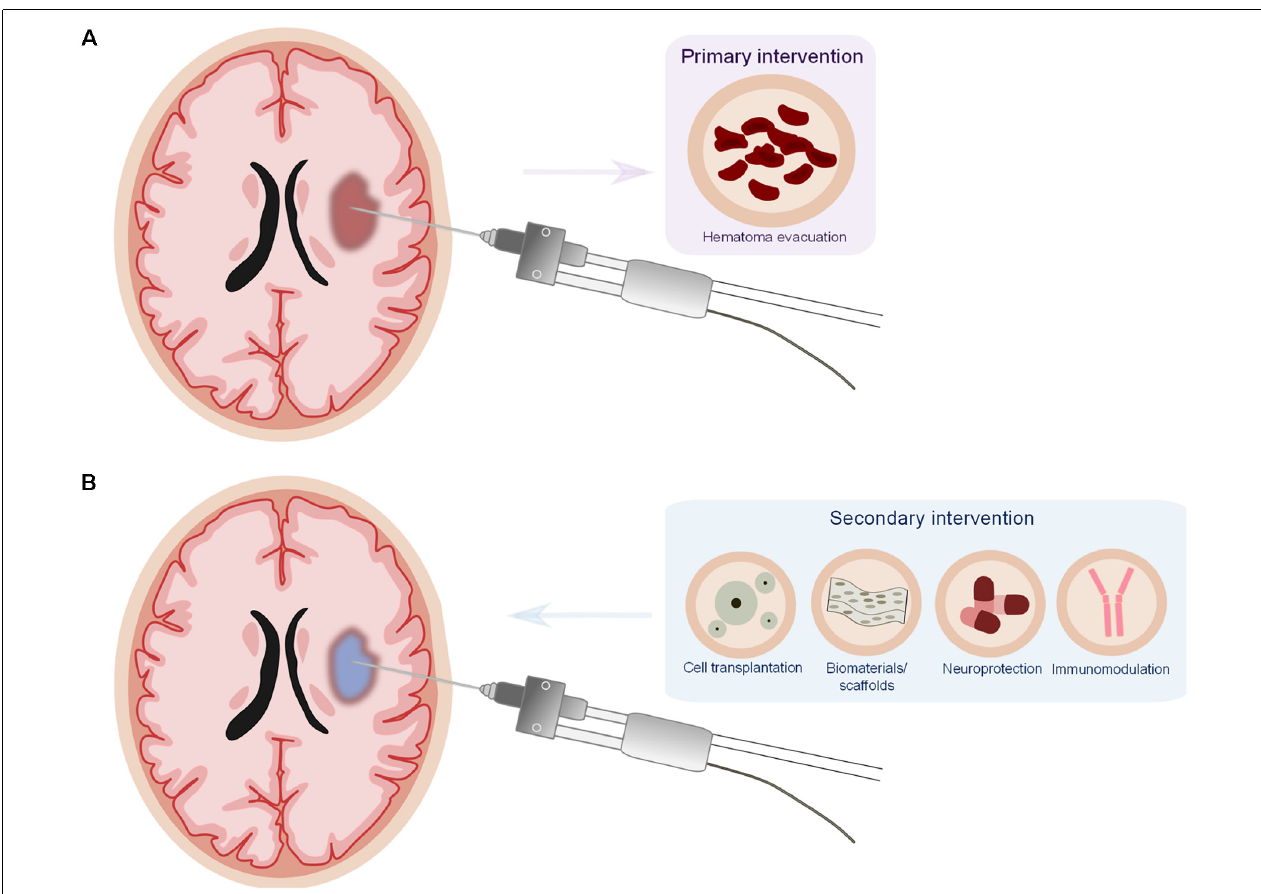
FIGURE 1 | Proposed model for a combinatorial therapy in intracerebral hemorrhage (ICH). (A) Minimally invasive surgery for the evacuation of the hematoma (primary intervention). (B) Minimally invasive surgery offers the particular opportunity to deliver potential therapeutics (cell transplantation, biomaterials/scaffolds, neuroprotective, and/or immunomodulatory drugs) as secondary intervention directly into the lesion site, reducing drug delivery issues and potential systemic side effects of the